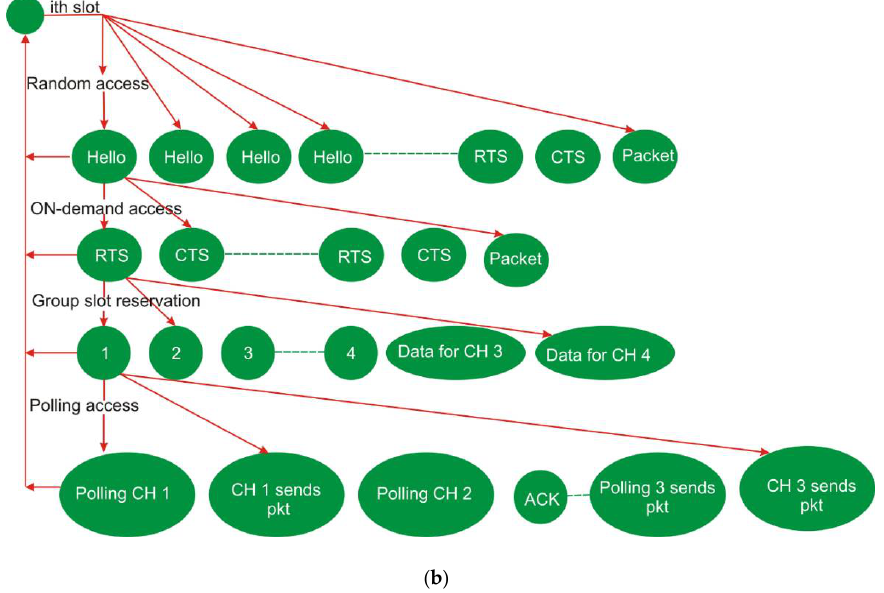
Figure 5. ( a ): Diagram of ECMA protocol. ( b ): Merge cluster head channel access.